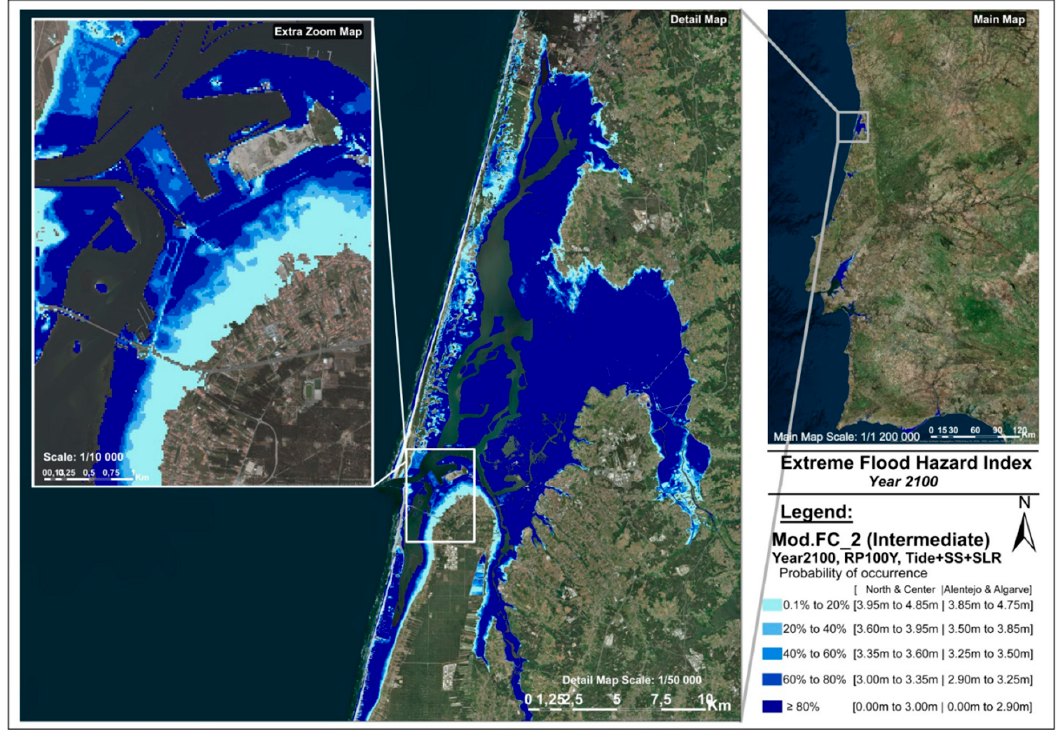
Figure 9. Portuguese coastal flooding extreme scenarios for 2100 SLR and 100-yr RP, within a zoom image of the Aveiro inland lagoon (Ria de Aveiro). Table 8. Flooding areas (in km 2 ) for each EFHI class interval and respective probability, for the SLR 2100 scenario in each coastal district.